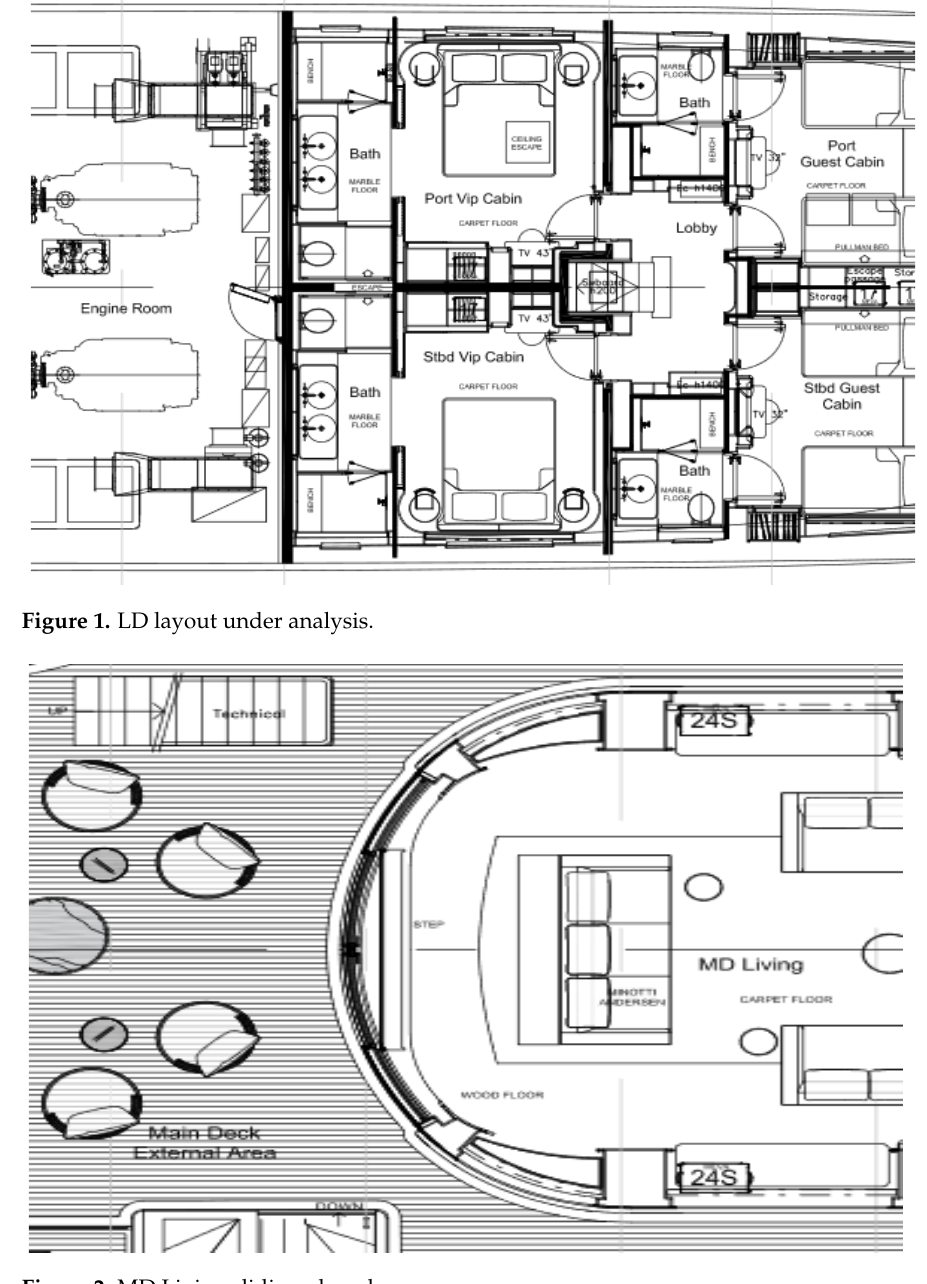
Figure 2. MD Living sliding glass door.